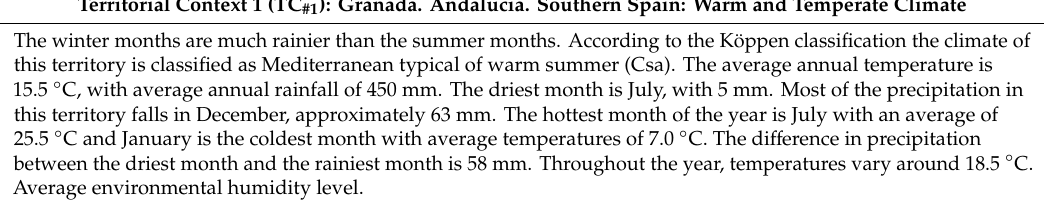
Table 1. Description of Territorial Context 1.